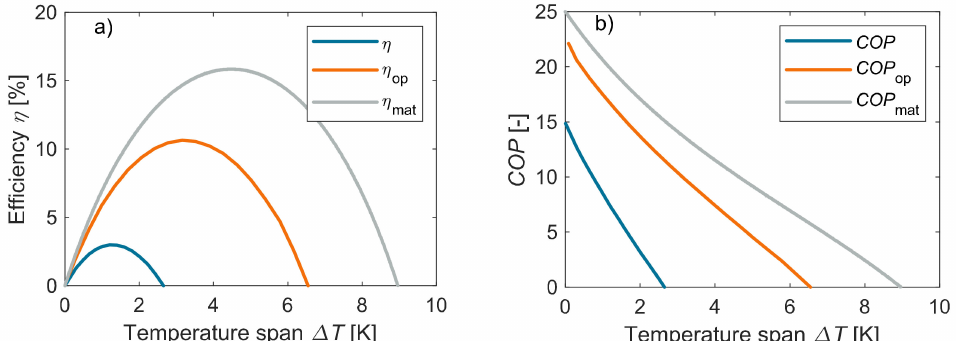
Figure 12. Simulation of the efficiency with improved system parameters. ( a ) The efficiency of the optimized system η op compared with the efficiency of the AEH of η . The optimized system achieved 67% of the material efficiency η mat . ( b ) The COP of the AEH compared with the COP op with optimized parameters and that of the material COP mat